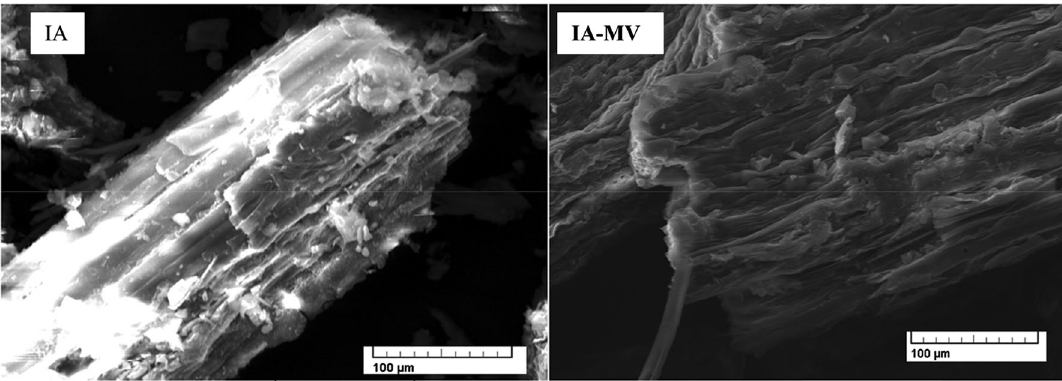
Fig. 9 Scanning electron micrographs of IA before (left) and after (right) adsorption of MV2B at 500× magnification